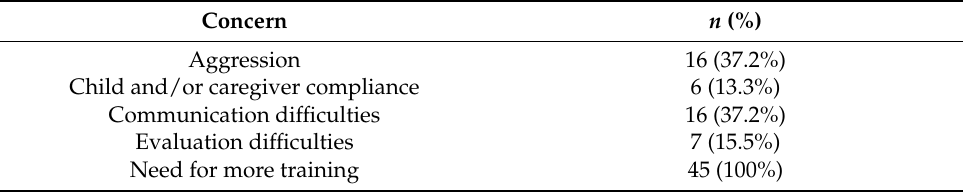
Table 1. Main concerns raised by HPs when taking care of patients with ASD ( n = 45).